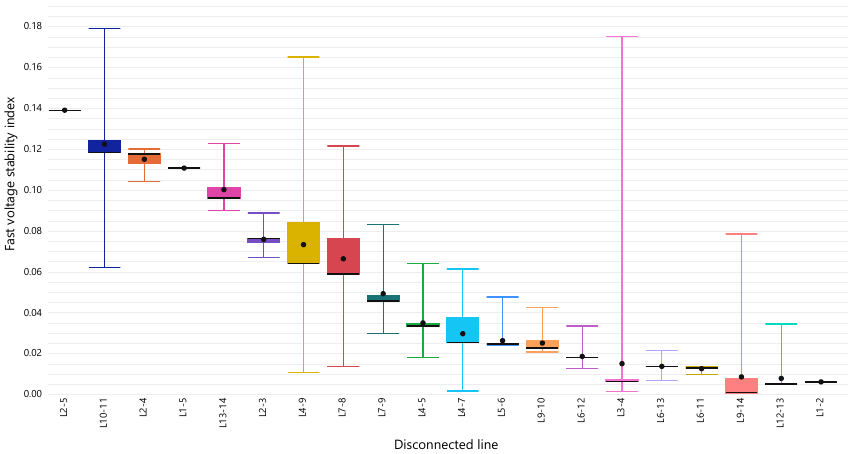
Figure 3. Fourteen-bus-bar system: statistical analysis for every contingency scenario. Continuing with Algorithm 2, after all contingencies are generated in step 3, step 4